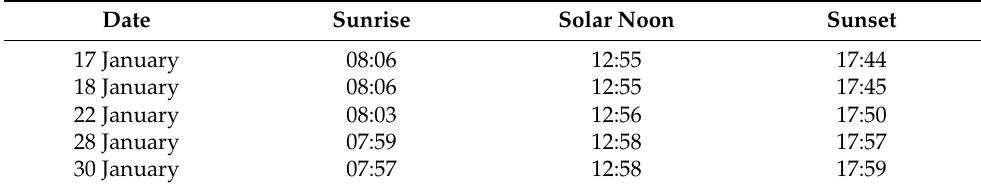
Table 2. The sunrise, solar noon, and sunset times of the days in Figure 3 (Beijing Time).